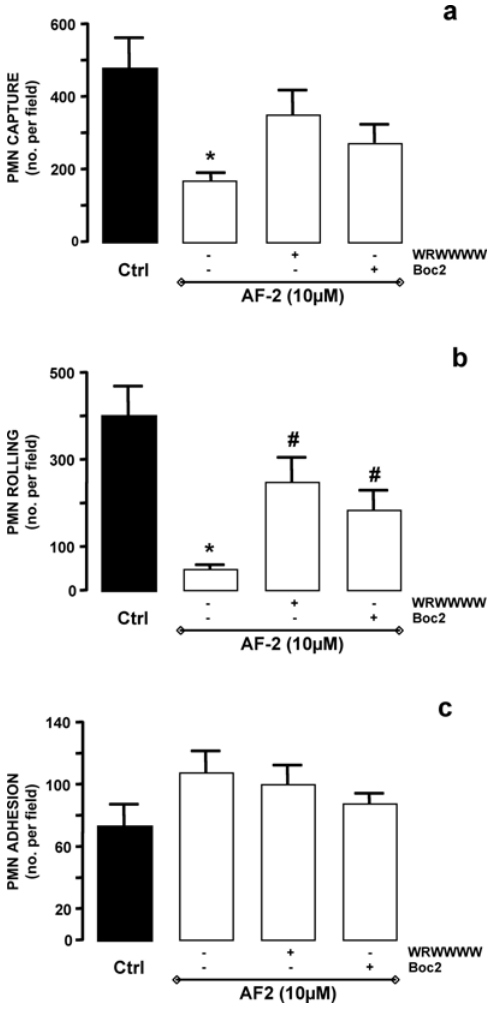
FIGURE 4. Effect of AF-2 on neutrophil interaction with HUVEC under flow . Neutrophils were incubated with 10 µ M AF-2 alone, with 10 µ M WRWWWW or with 10 µ M Boc2, for 10 min prior to flow over TNF- α stimulated (10 ng/ml, 4 h) HUVEC. Neutrophil-endothelium interactions were quantified off-line. (a) Number of neutrophils captured. (b) Number of rolling neutrophils. (c) Number of firmly adherent neutrophils. Data are presented as mean ± SEM of four to six independent experiments. ∗ p < 0.05 vs. control group; # p < 0.05 vs. AF-2 alone